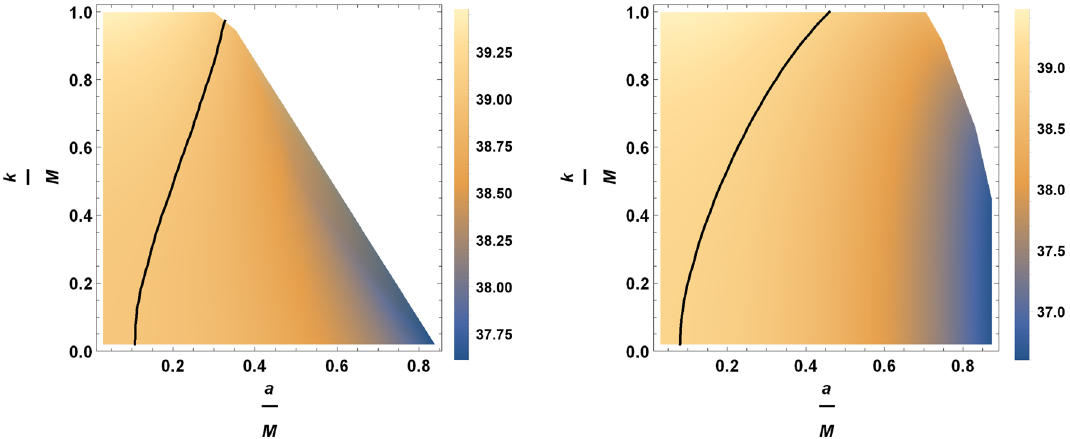
Fig. 23 The observable for angular diameter θ d as a function of black hole parameters. The left one is for l = 0 . 1, b = 0 . 1, and angle of inclination θ = 90 ◦ . The right one is for l = 0 . 1, b = 0 . 1, and θ = 17 ◦ . Black solid lines correspond to θ